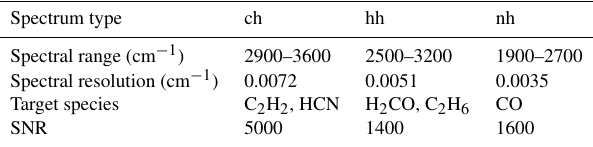
Table 2. The characters of the three types of spectra observed at Xianghe used to retrieve CO, C 2 H 2 , C 2 H 6 , H 2 CO, and